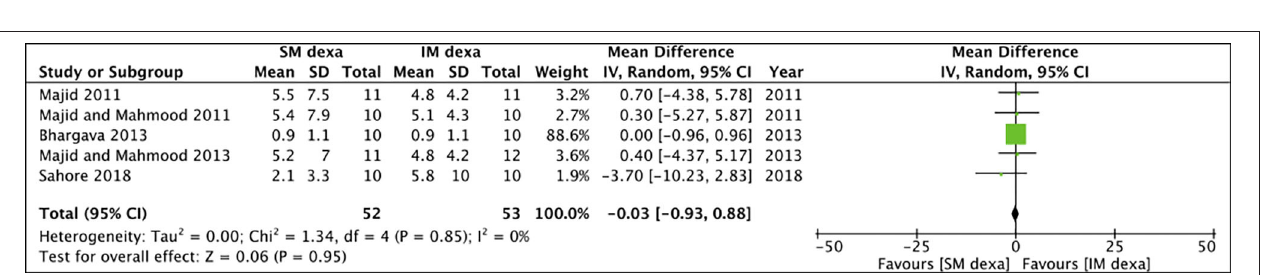
FIGURE 13 | Meta-analysis of late trismus between SM and IM dexamethasone (dexa) for third molar